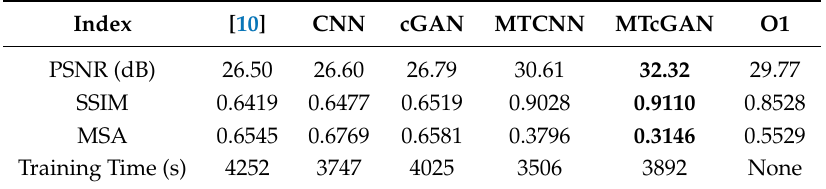
Table 3. The evaluation values of PSNR, SSIM, MSA and training time of different methods in Case